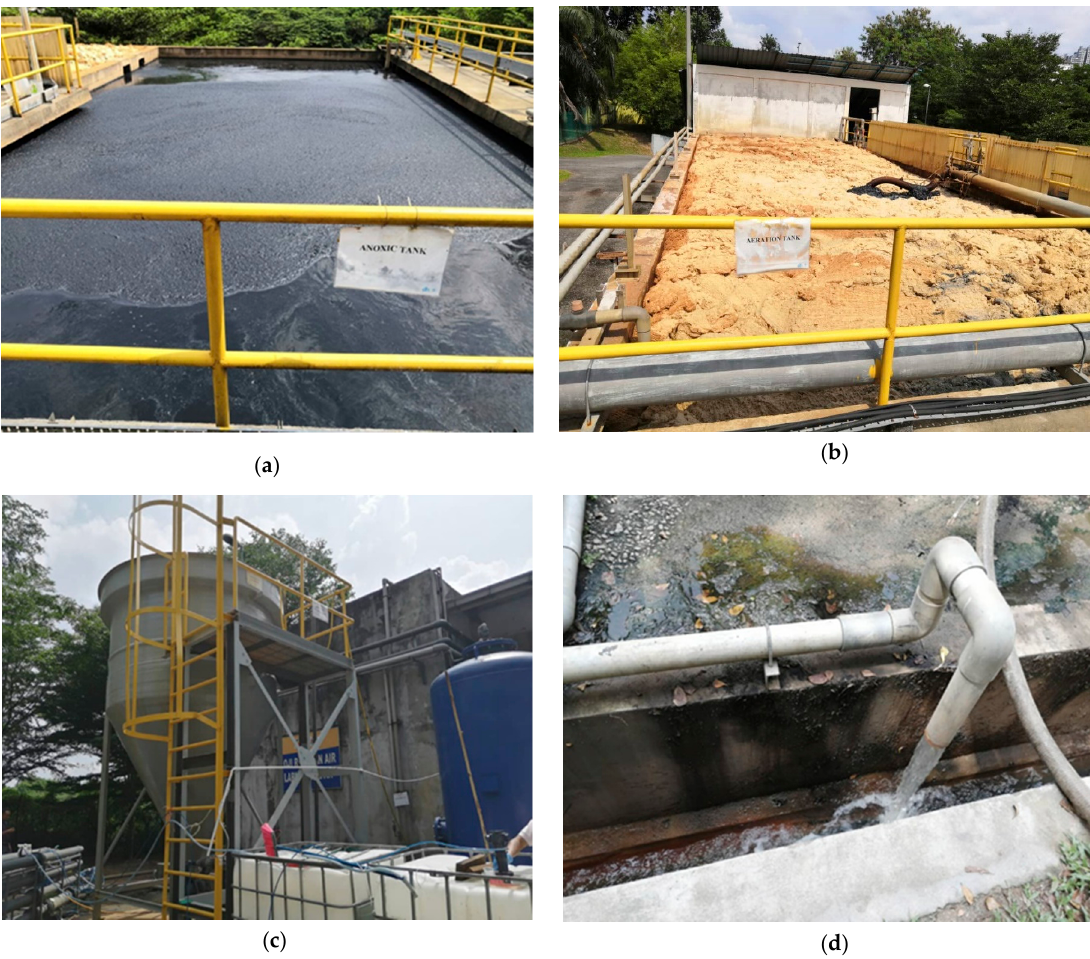
Figure 4. Sampling points. ( a ) Anoxic tank, ( b ) aeration tank, ( c ) secondary clarifier tank, ( d ) final discharge point.